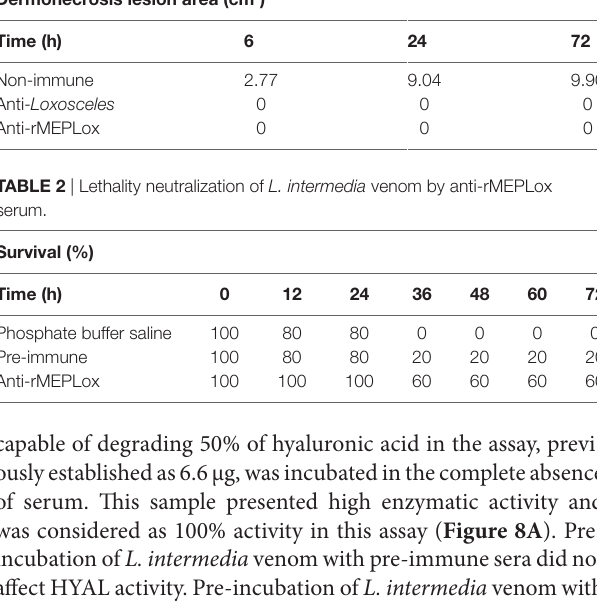
TaBle 1 | Measurement of dermonecrosis area (squared centimeters) caused by 10 µg of L. intermedia venom in immunized rabbits. Dermonecrosis lesion area (cm 2 )